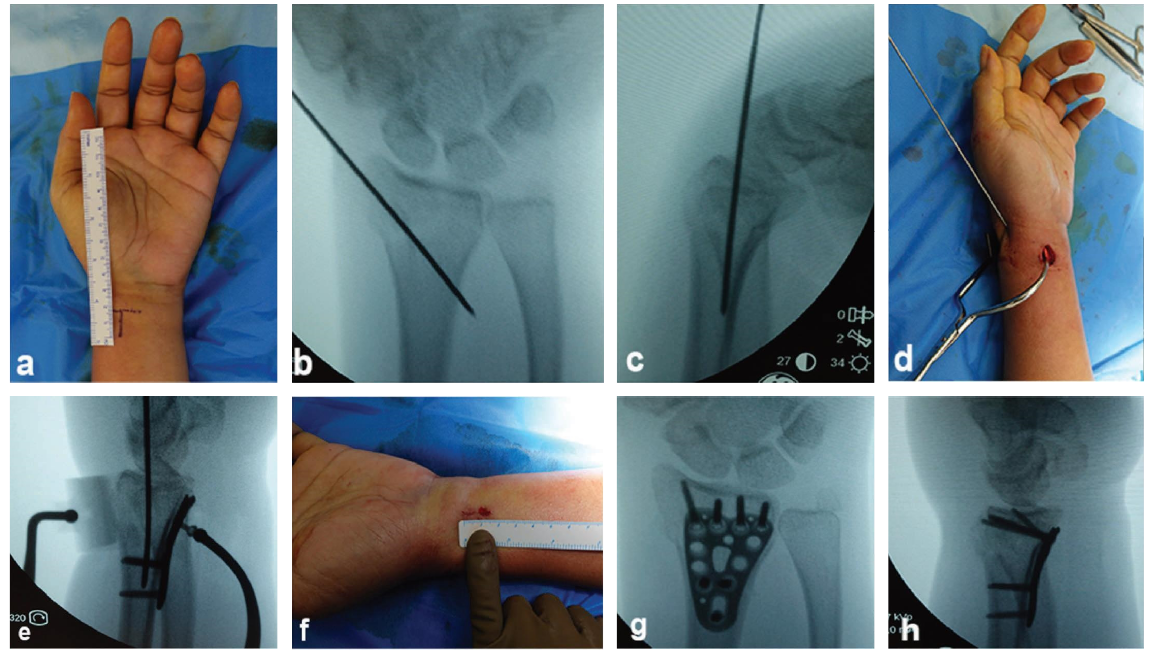
Figure 1: Minimally invasive plating using the extra-articular technique in Case 1: (a) incision design, (b, c) closed reduction and provisional fxation using K-wire, (d, e) soft tissue-bone reduction forceps were used to grip the plate over the bone, (f) the 15 mm wound was closed with an absorbable suture, and (g, h) the fnal result viewed under an image